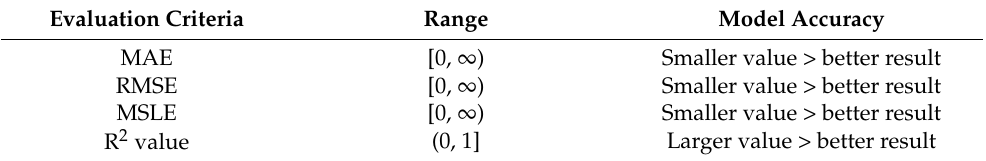
Table 8. Error ranges associated with statistical